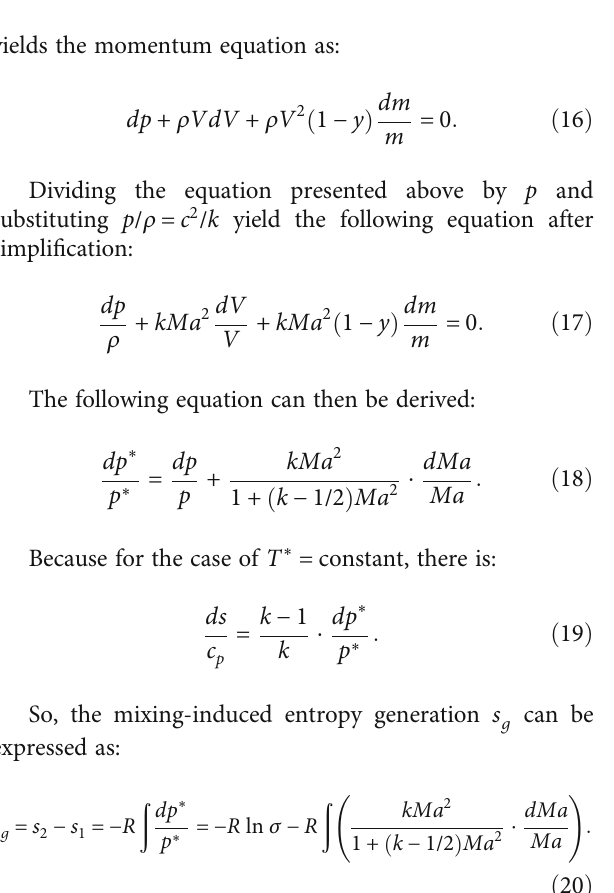
Figure 4: The entropy generation is only induced by mixing